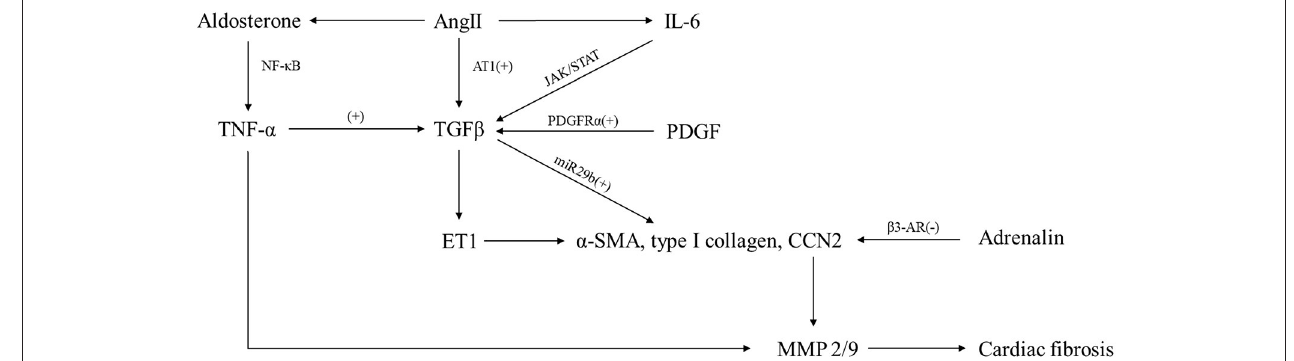
FIGURE 4 | Molecular pathways participated in cardiac